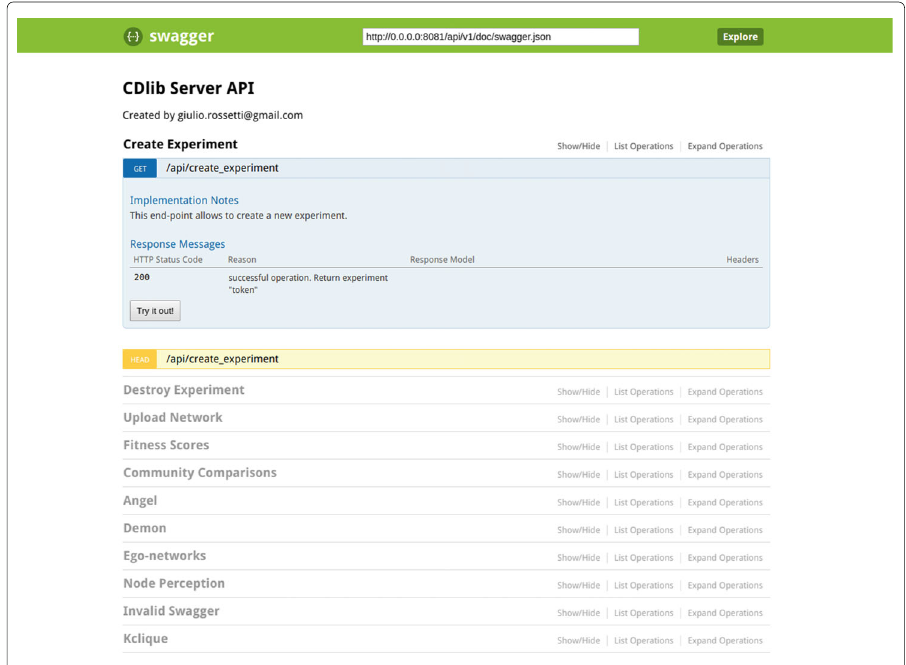
Fig. 4 CDlib-REST webpage of the